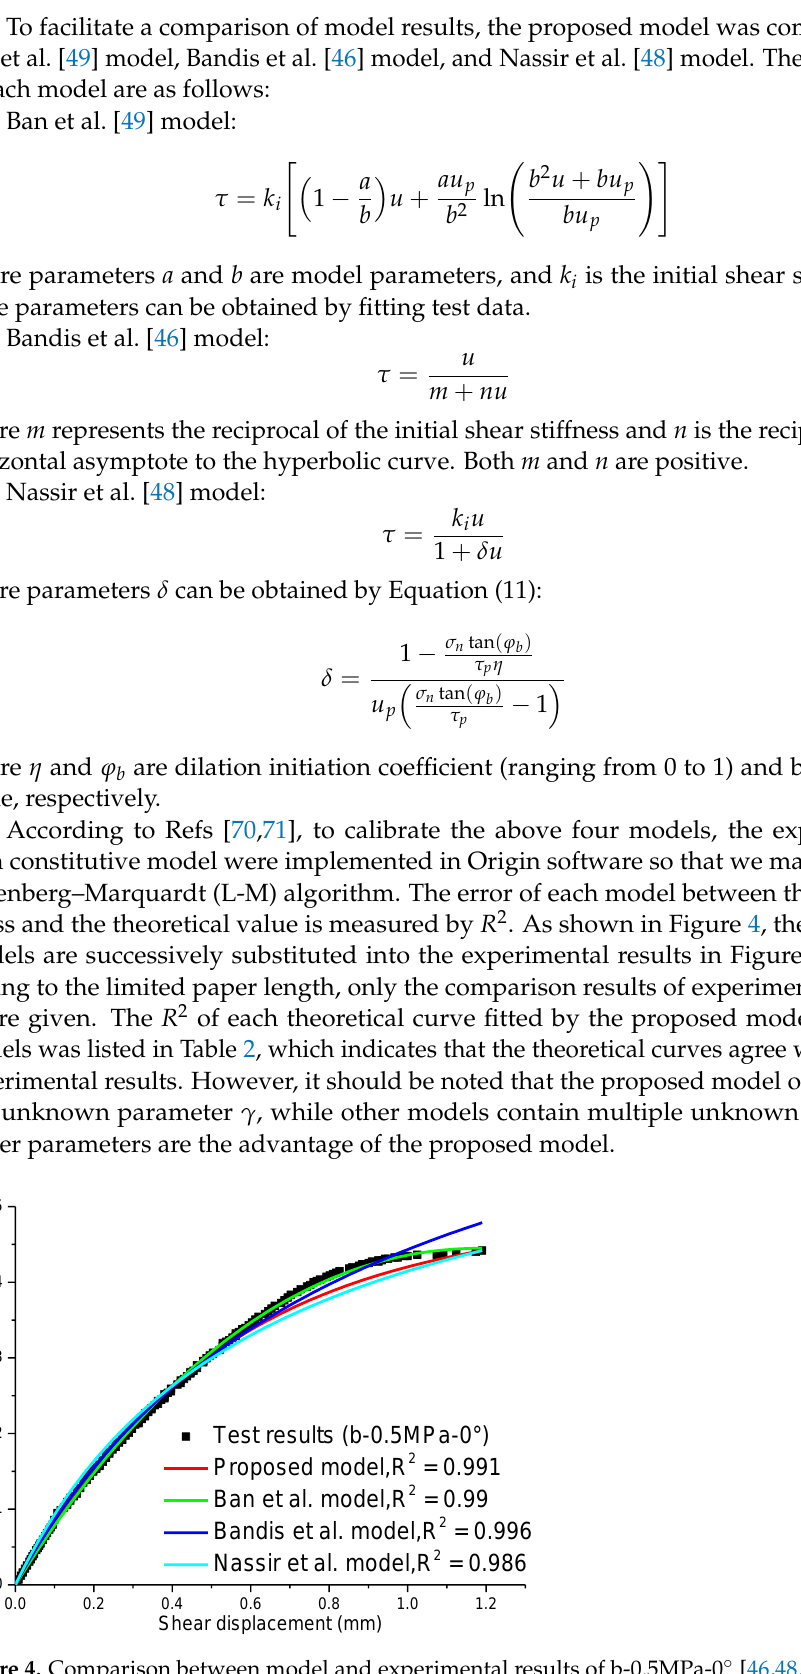
Figure 4. Comparison between model and experimental results of b-0.5MPa-0 ° . Table 2. Fitting effect of model and experimental results.